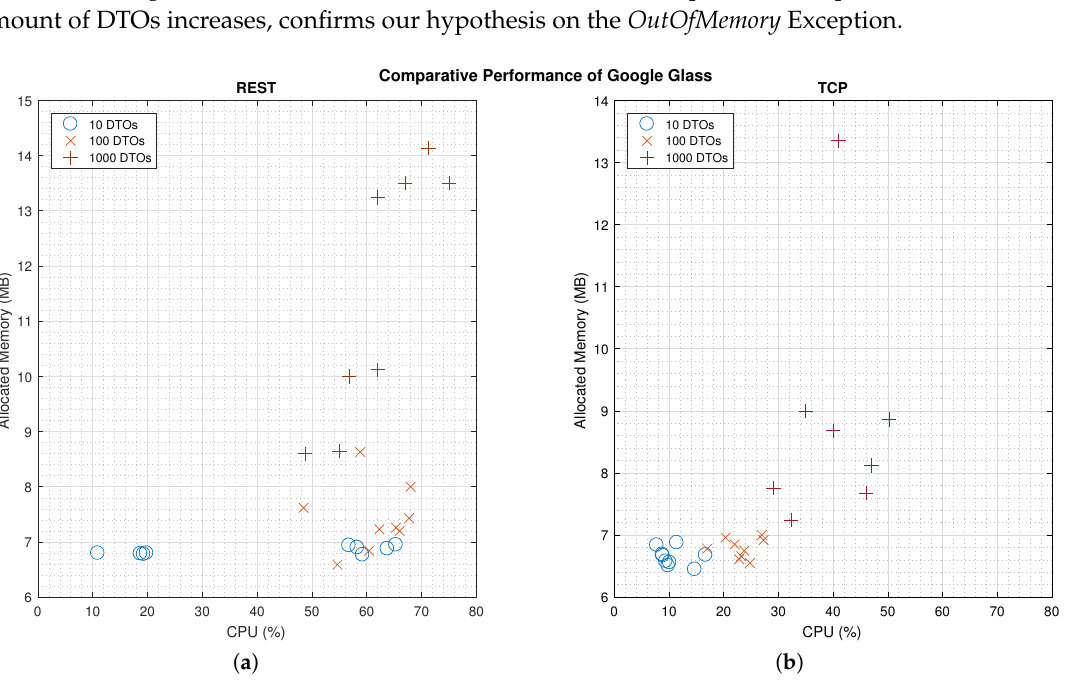
Figure 4. Comparison on the performance of Google Glass (CPU and Memory) for the two communication schemes. The exponential slope of the cross-points confirms our hypothesis in the Memory management and OutOfMemory Exception, eventhough the ( b ) figure shows a better CPU management than ( a ). ( a ) Results on the performance of REST messages management; ( b ) Results on the performance of TCP messages